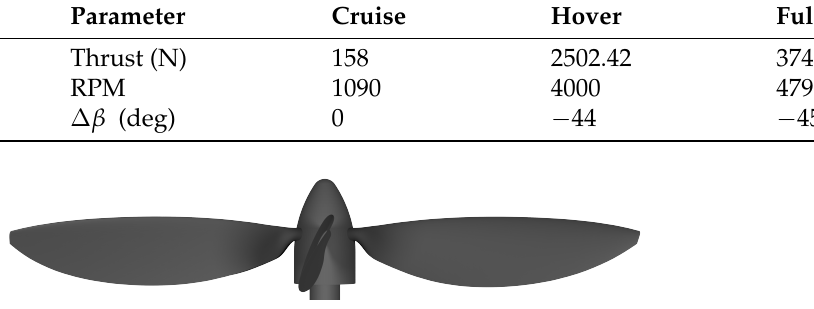
Figure 6. Side view of the blade angle under cruise conditions.